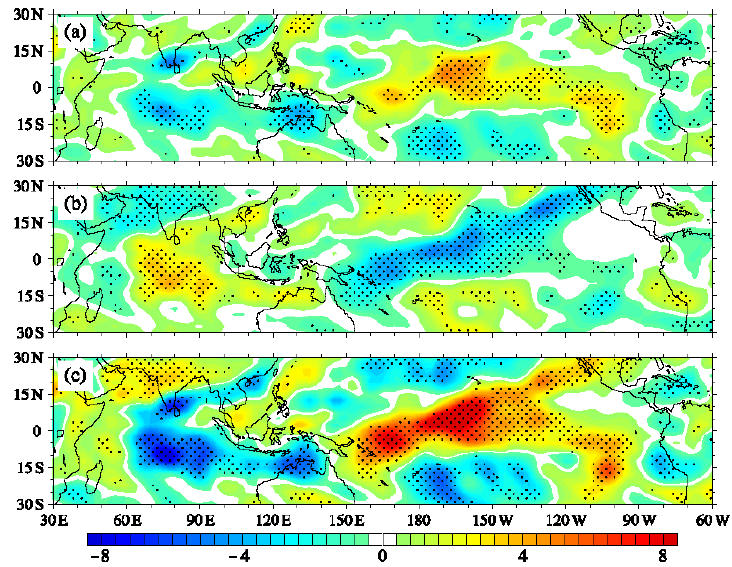
Figure 3. As in Figure 1, but for the anomalous MJO OLR amplitude (w·m −2 ). ( a ) positive phases, ( b ) negative phases, and ( c ) their difference.